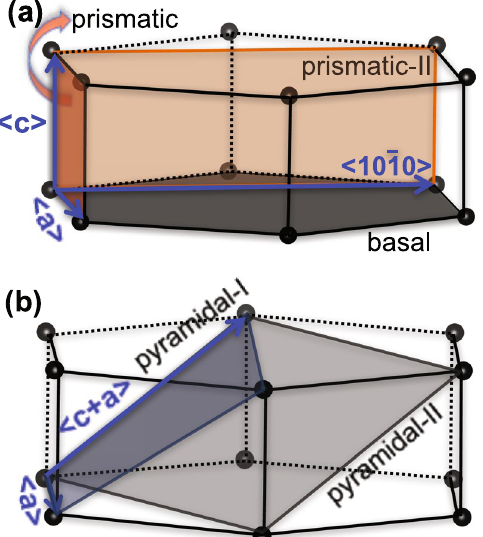
Figure 1. Schematic showing the possible slip modes on different planes in ω -Zr. ( a ) basal 〈 a 〉 and basal 1010 slip modes on the basal plane; prismatic 〈 a 〉 and prismatic 〈 c 〉 ) slip modes on the prismatic plane; and prismatic-II 1010 and prismatic-II 〈 c 〉 slip modes on the prismatic-II plane, ( b ) pyramidal-I 〈 a 〉 and pyramidal-I 〈 c + a 〉 slip modes on the pyramidal-I plane; and pyramidal-II 〈 c + a 〉 slip modes on the pyramidal-II plane.